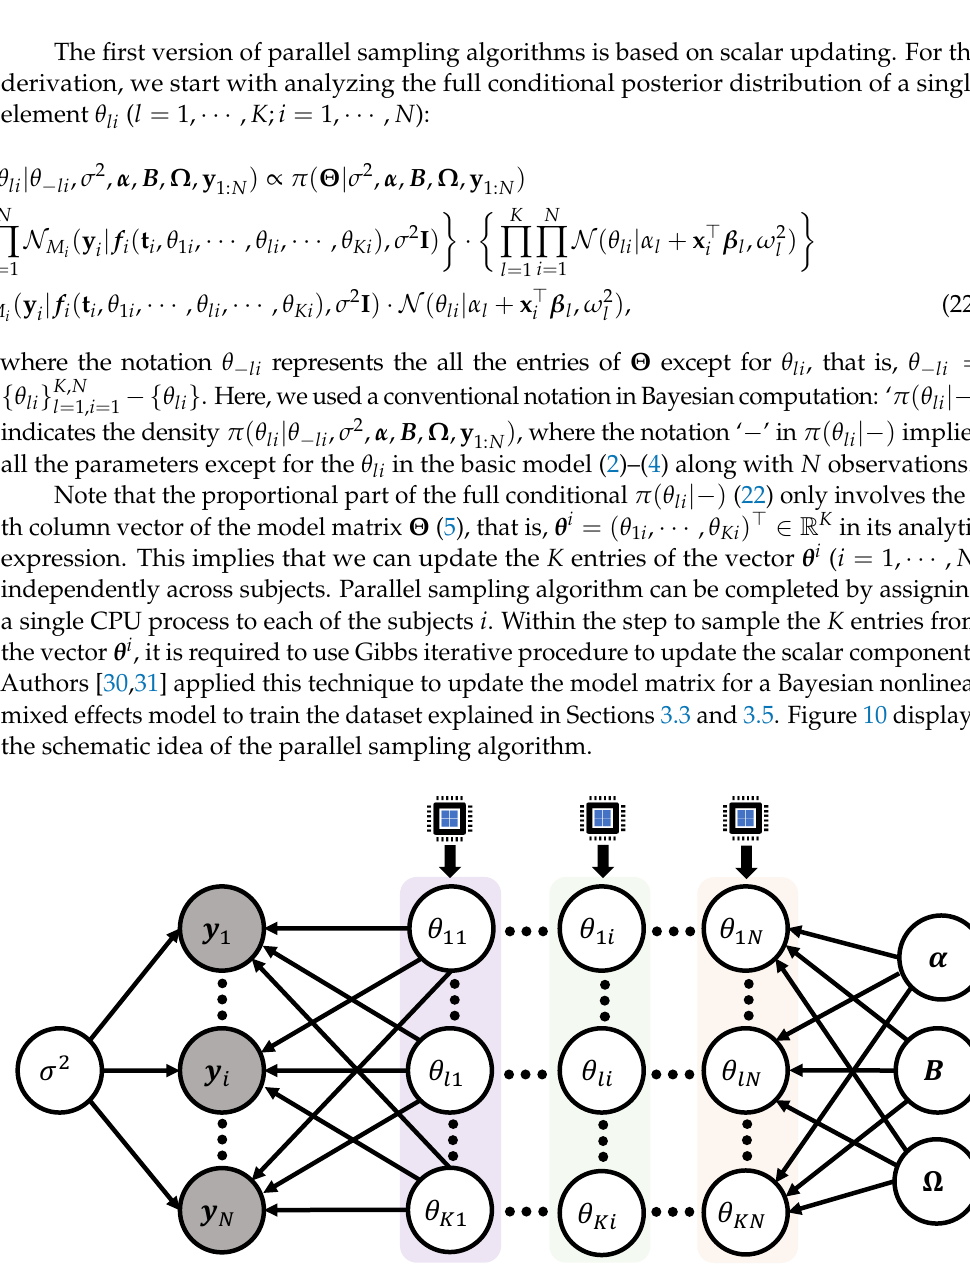
Figure 10. A pictorial description on the use of parallel computation to the basic model (2)–(4) to update the model matrix Θ = [ θ 1 · · · θ i · · · θ N ] ∈ R K × N (5). In the parallel computation, a single CPU is assigned to an individual subject i = 1, · · · , N